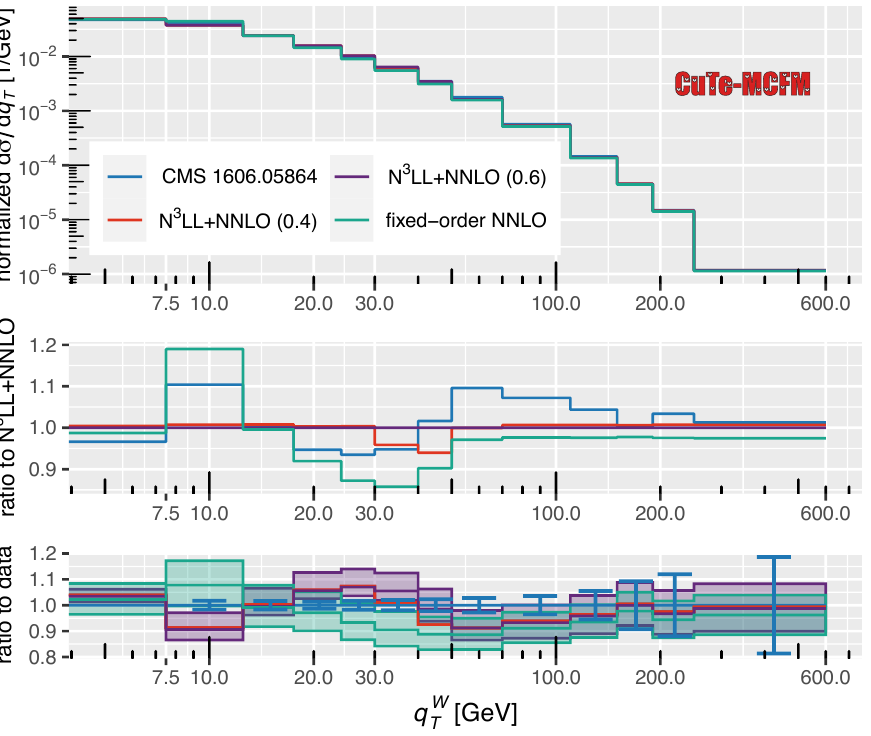
Figure 11. Comparison to normalized W transverse-momentum data from CMS at 8 TeV with predictions at N 3 LL+NNLO including uncertainties associated with scale